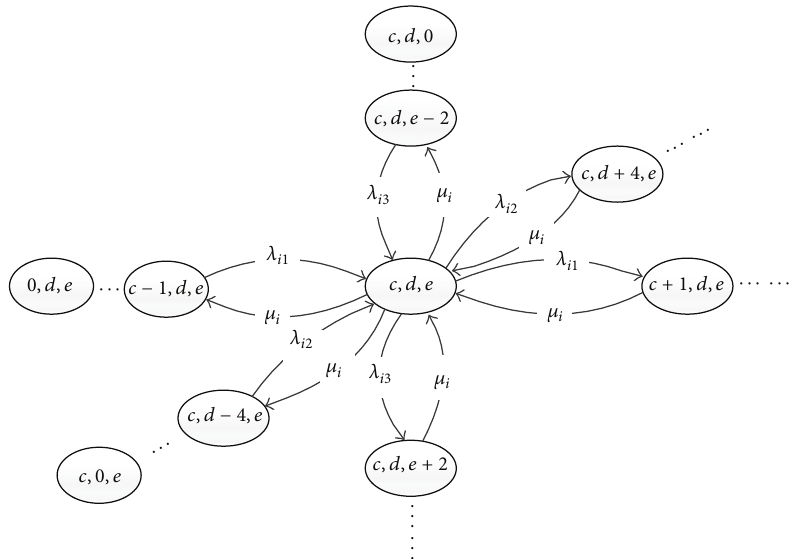
Figure 2: The three-dimensional Markovian model for the PRB occupation of cell 𝑖 .